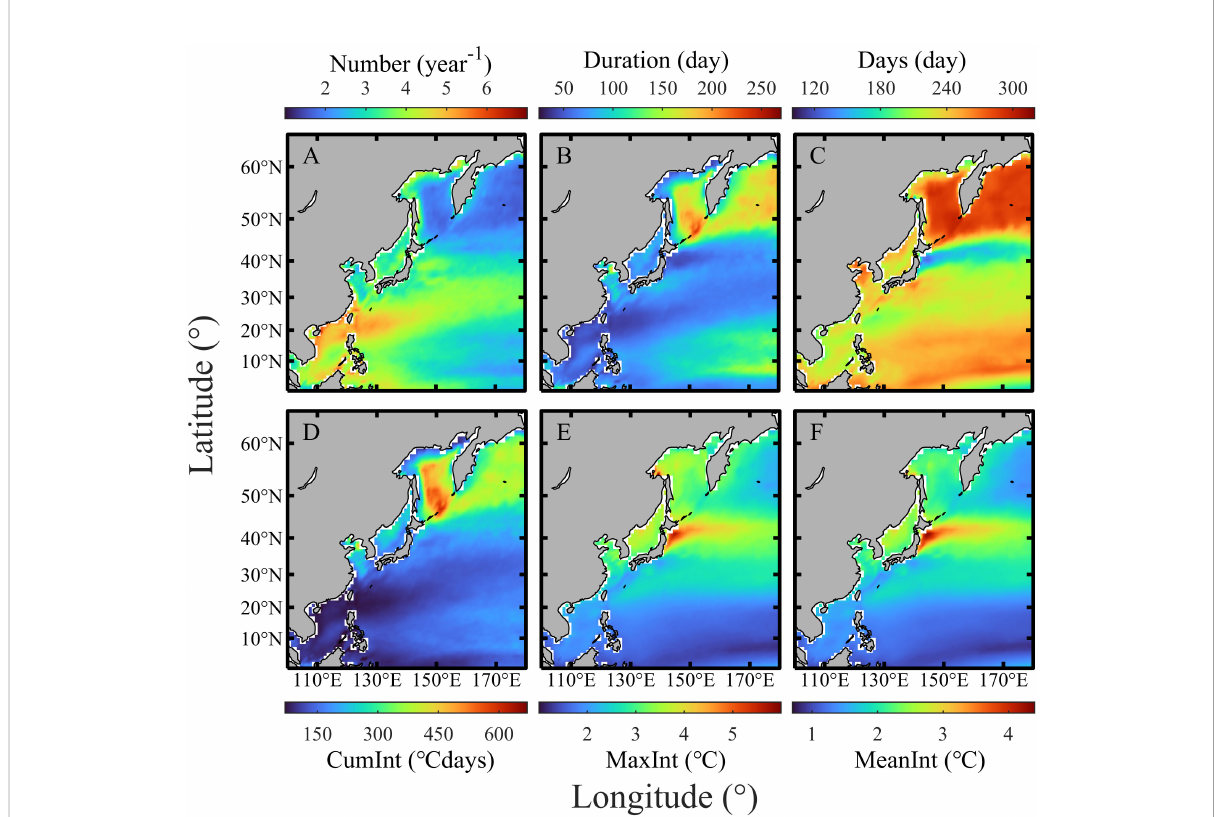
FIGURE 7 Spatial distribution of projected (2015 ~ 2100) MHWs characteristics in the WNPCC area under the SSP2-4.5 scenario. Multi-year average of MHWs (A) Number (units: year -1 ), (B) Duration (units: day), (C) Days (units: day), (D) CumInt (units: °C days), (E) MaxInt (units: °C), and (F) MeanInt (units: